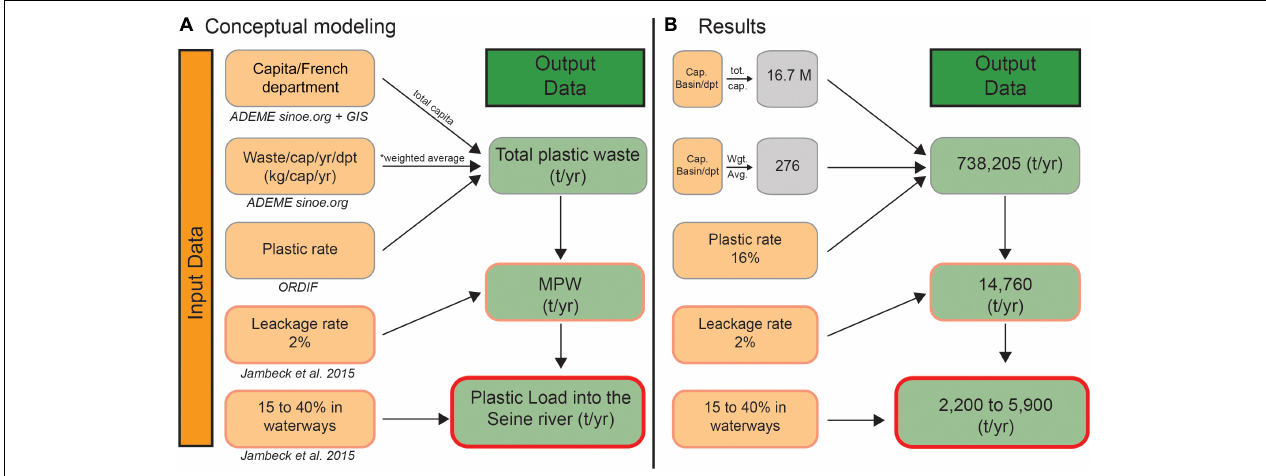
FIGURE 1 | (A) Conceptual model modified from Jambeck et al. (2015) and (B) Results for the Seine catchment. In italics, sources of input data. The red boxes indicate the robustness of the data: the more intense the red, the less robust the output data. MPW, mismanaged plastic waste. ∗ This takes into account differences in waste production between the french departments included in the